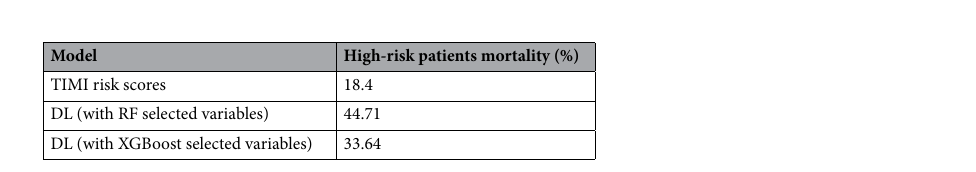
Table 5. Percentage of mortality of TIMI score (> 5) and DL-based on risk stratification (> 0.4).